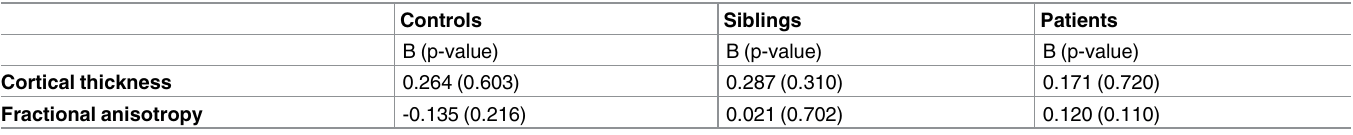
Table 2. Associations between S100B and cerebral structural